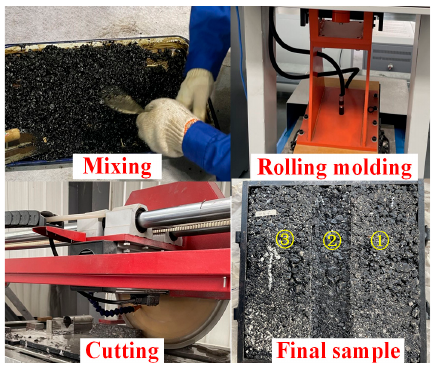
Figure 1. Specimen preparation and cutting.